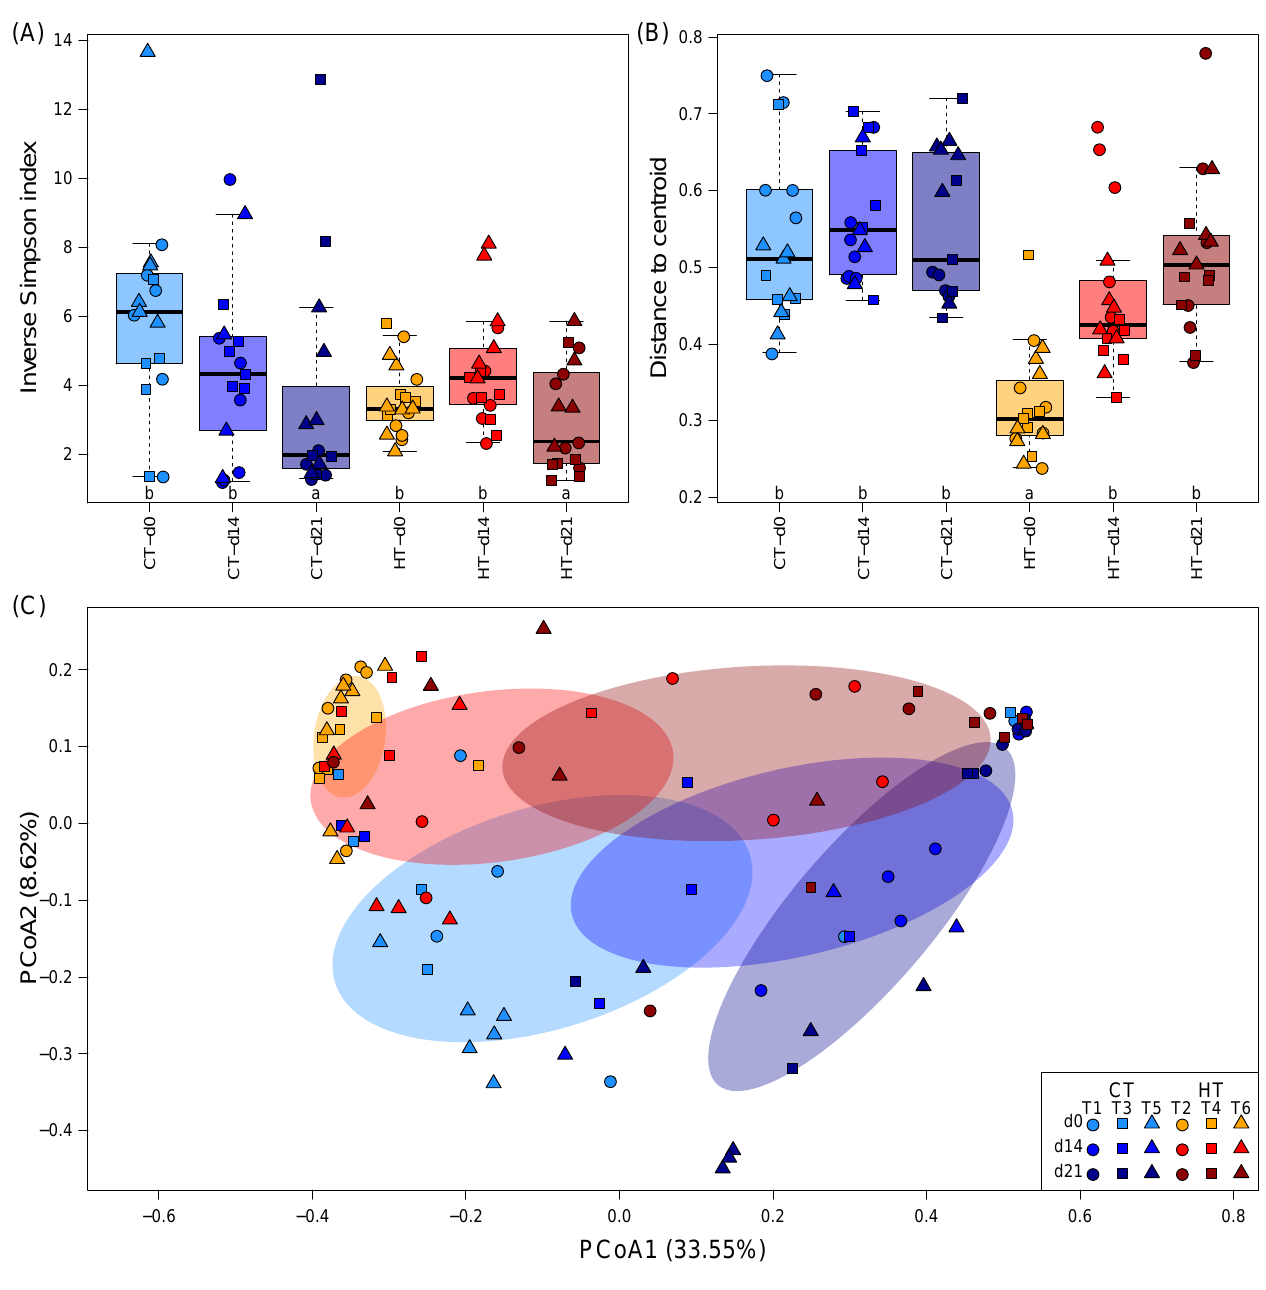
Figure 2. Alpha and beta diversity of the milkfish gut microbiome at different temperature treatments and sampling timepoints. ( A ) Alpha diversity (inverse Simpson index). ( B ) Betadispersion (distance to centroid). In A and B, lower case letters indicate significant differences between groups of samples. ( C ) Principal coordinate analysis (PCoA). Percentages in parenthesis indicate the amount of variation shown on each axis. The shaded ellipses show the 95% confidence interval of the centroid of each group. Temperature treatments: control temperature at 26 ◦ C (CT) and high temperature at 33 ◦ C (HT). Sampling timepoints: 0, 14, and 21 days after the temperature increase. Each treatment consisted of three independent tanks (T: tank